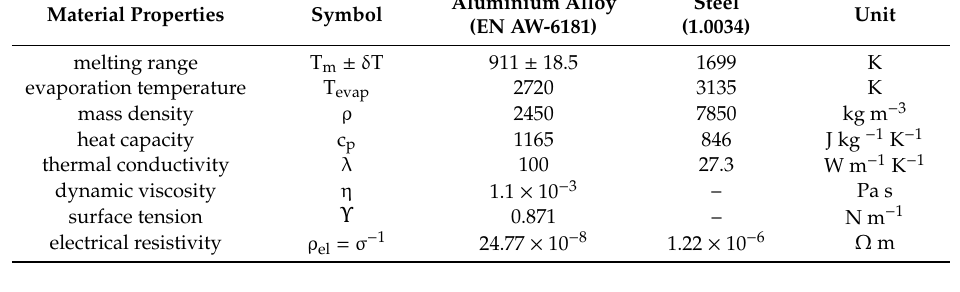
Table 2. Material properties of air at room temperature based on [15].